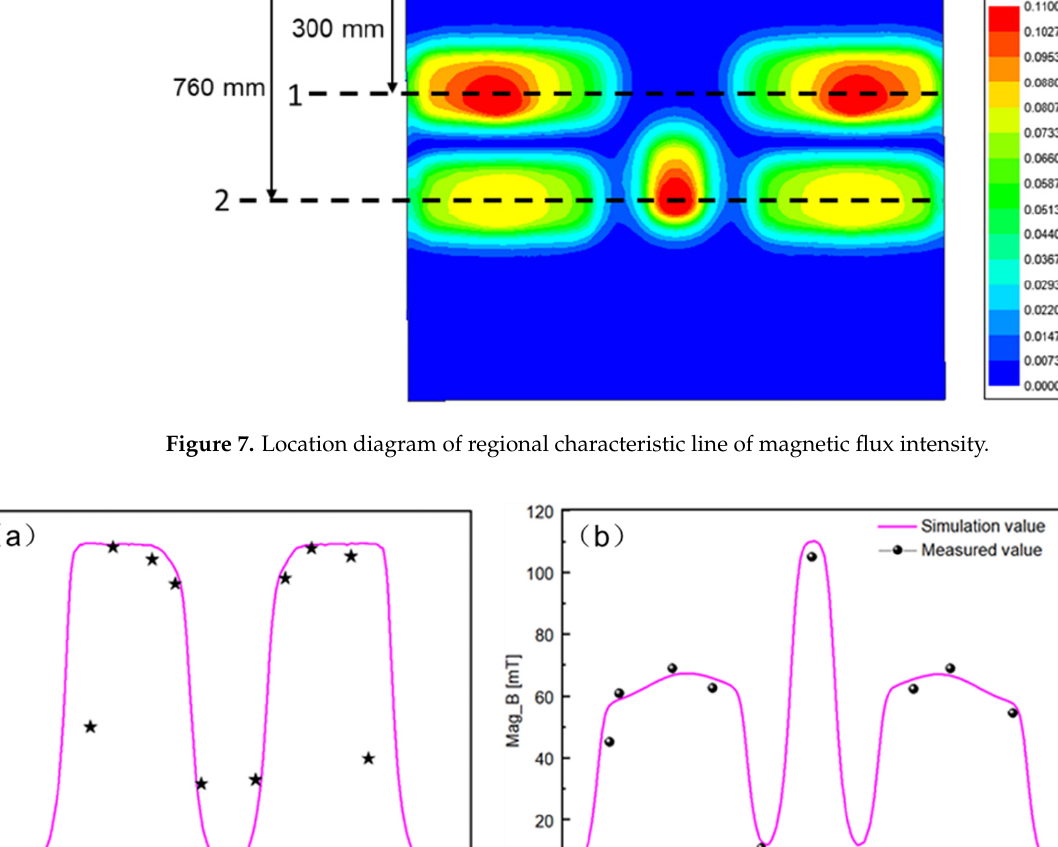
Figure 6. Funnel mold electromagnetic field vector diagram.